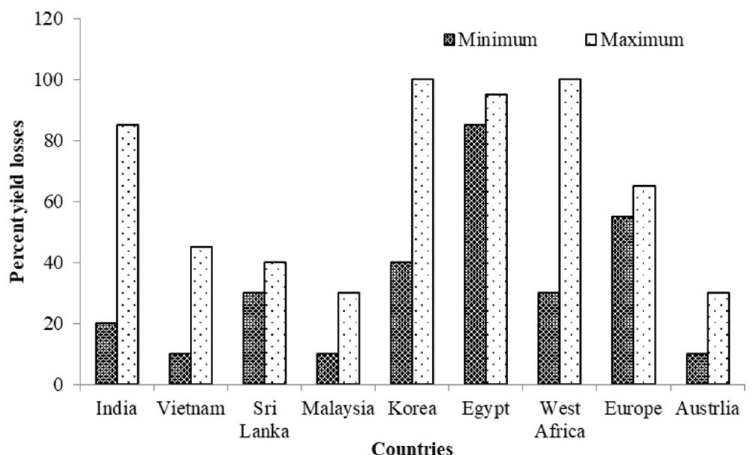
Figure 1. The extent of yield losses due to weeds in major dry direct-seeded rice (DDSR) growing ecologies of the world (Source: [14]).